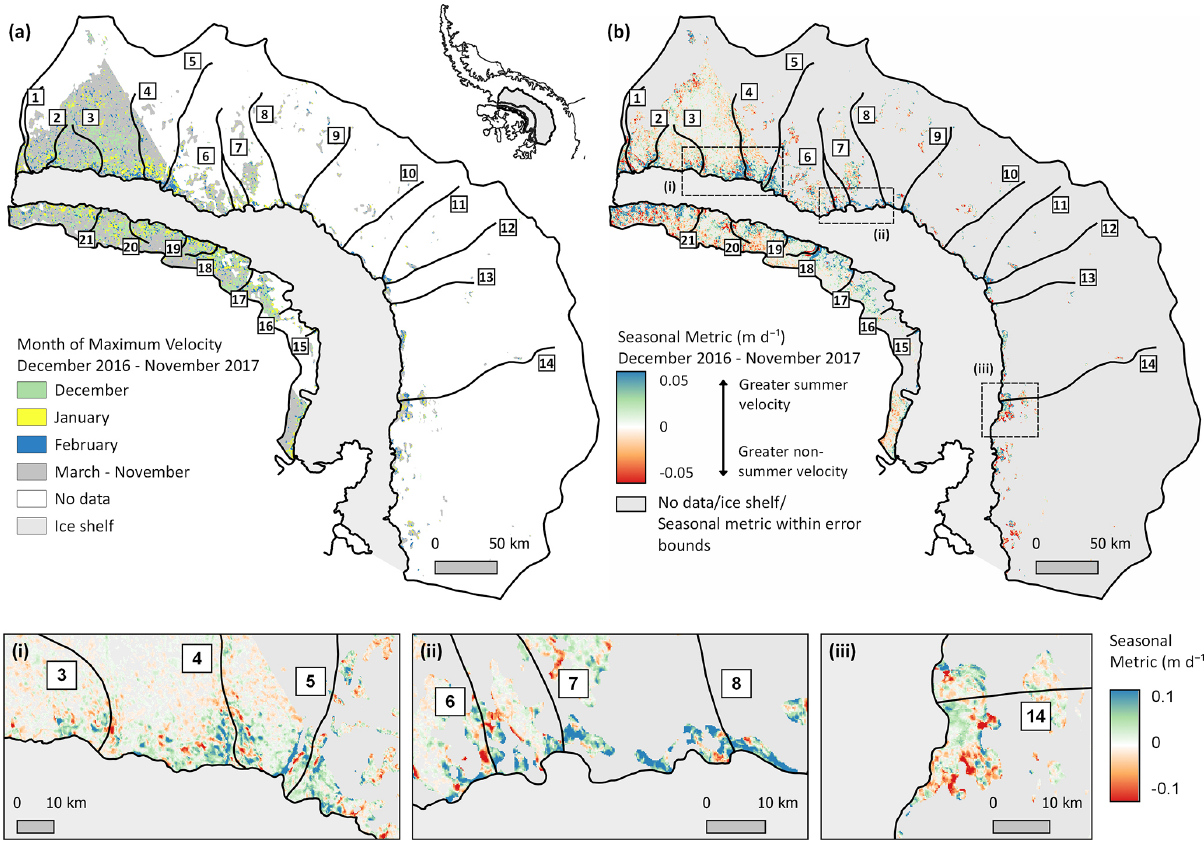
Figure B3. Same as Fig. 3 but showing spatially resolved patterns of seasonal ice flow as observed between December 2016 and Novem- ber 2017. Panel (a) shows the month of maximum velocity ( v time ) and (b) the calculated velocity anomaly ( v anom velocity anomalies (blue) indicate summertime speed-up and negative (red) greater velocity during non-summertime months. Dashed boxes denote the location of the inset boxes (i–iii). See also Figs. B1–B2 and